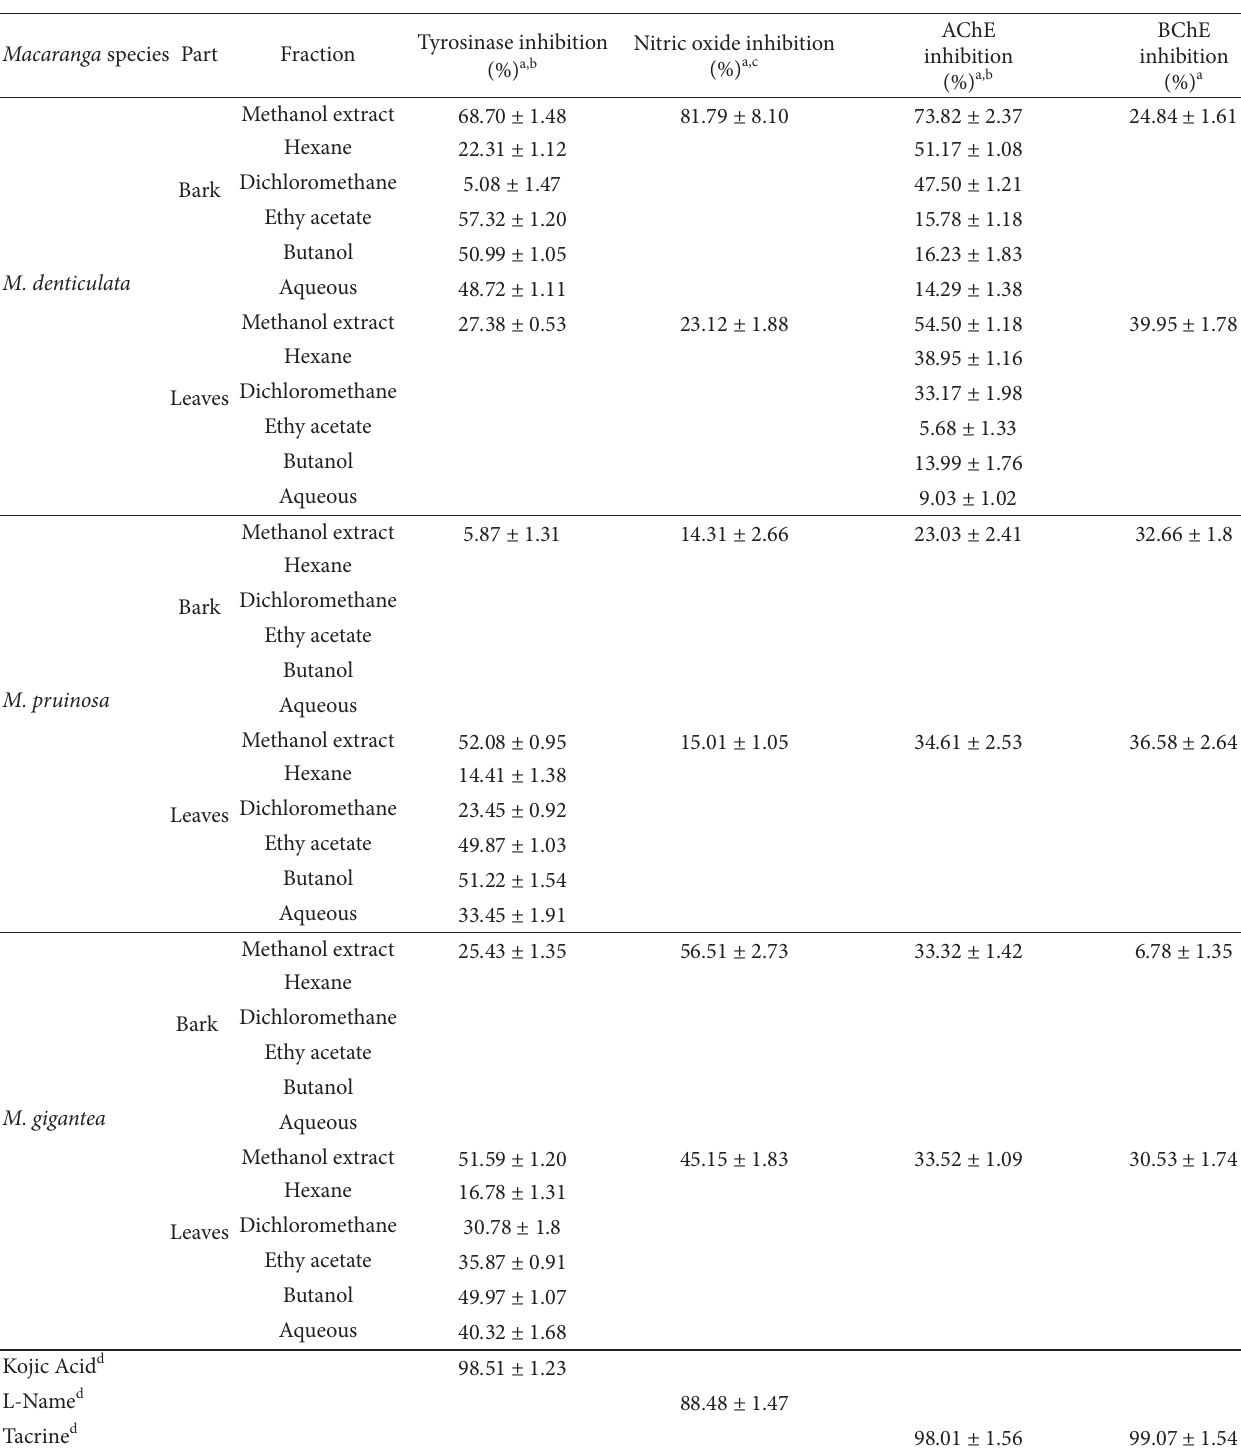
Table 2: Antityrosinase, nitric oxide, acetylcholinesterase (AChE), and butyrylcholinesterase (BChE) inhibitory activity of extracts and different polarity fractions of Macaranga